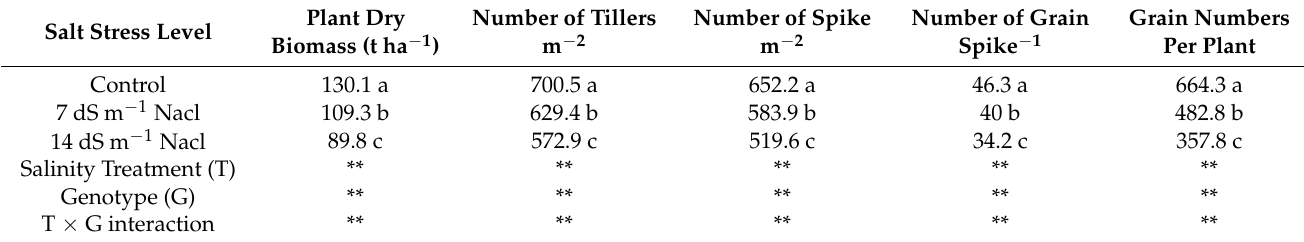
Table 3. Effect of salt stress on biomass and agro-physiological traits, and yield components across 6 barley genotypes.